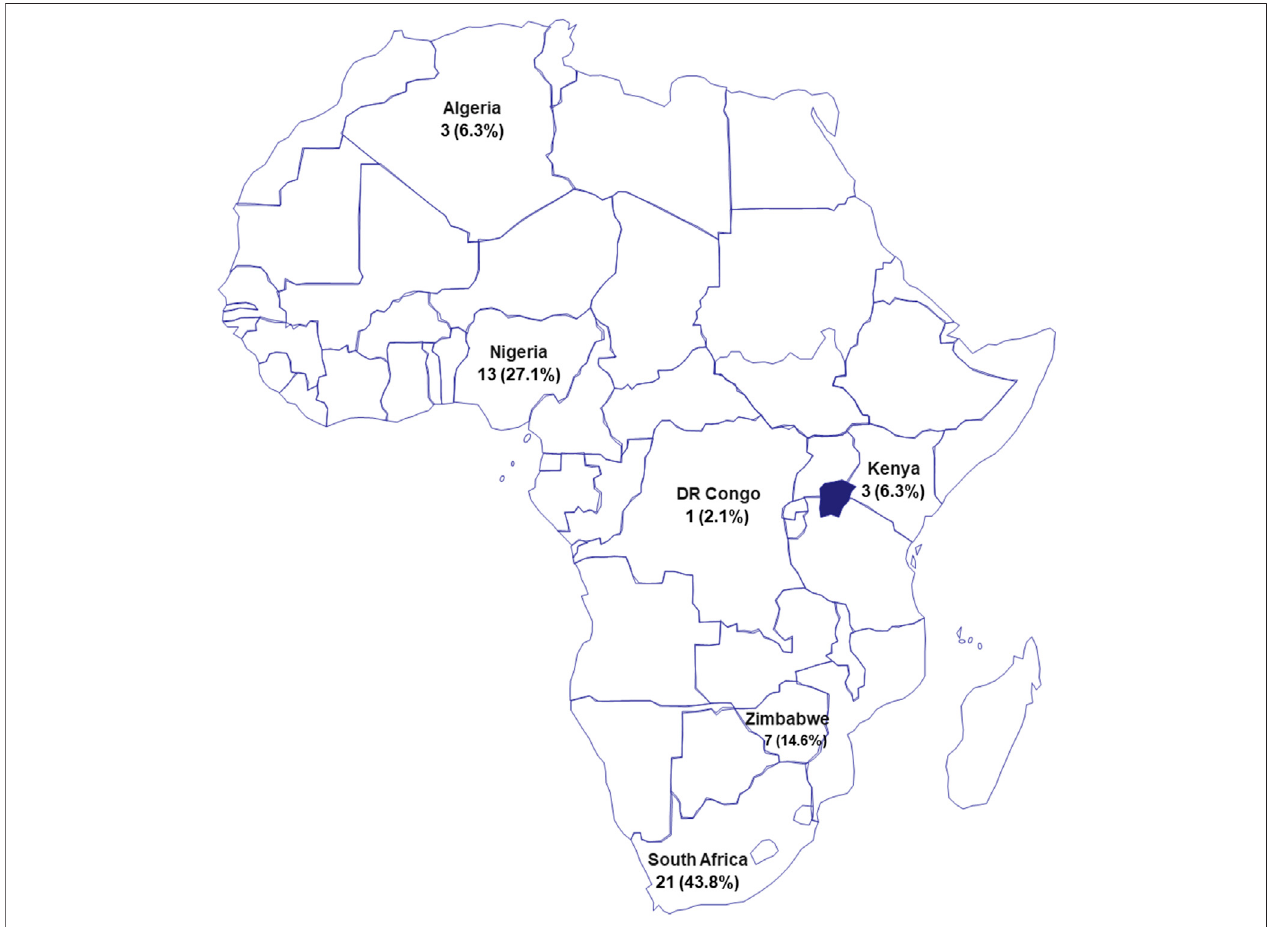
FIGURE 1 | Map of Africa showing the distribution of authors by country of af fi liated institution. Authors are from six countries shown in the map. Values represent number of authors and the proportion as percentages in parentheses.